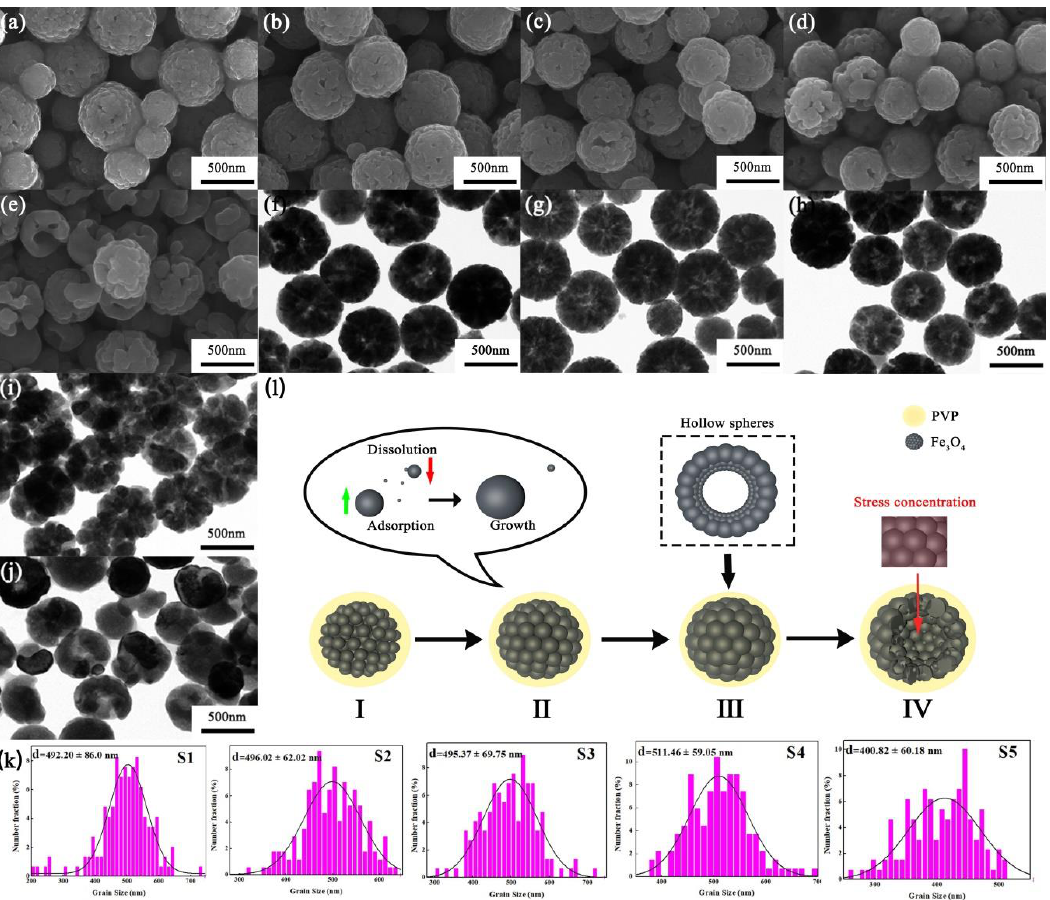
Figure 2. SEM of samples: ( a ) S1, ( b ) S2, ( c ) S3, ( d ) S4, ( e ) S5; TEM of samples: ( f ) S1, ( g ) S2, ( h ) S3, ( i ) S4, ( j ) S5; ( k ) Size distribution of Fe 3 O 4 samples; ( l ) Schematic diagram of the formation process of Fe 3 O 4 by Ostwald ripening.